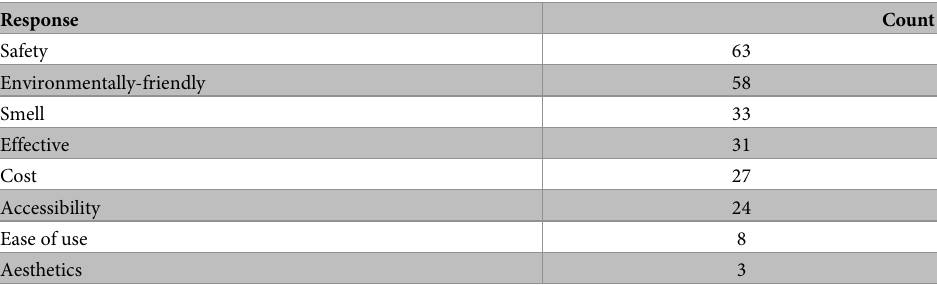
Table 1. Factors that determine mosquito control product